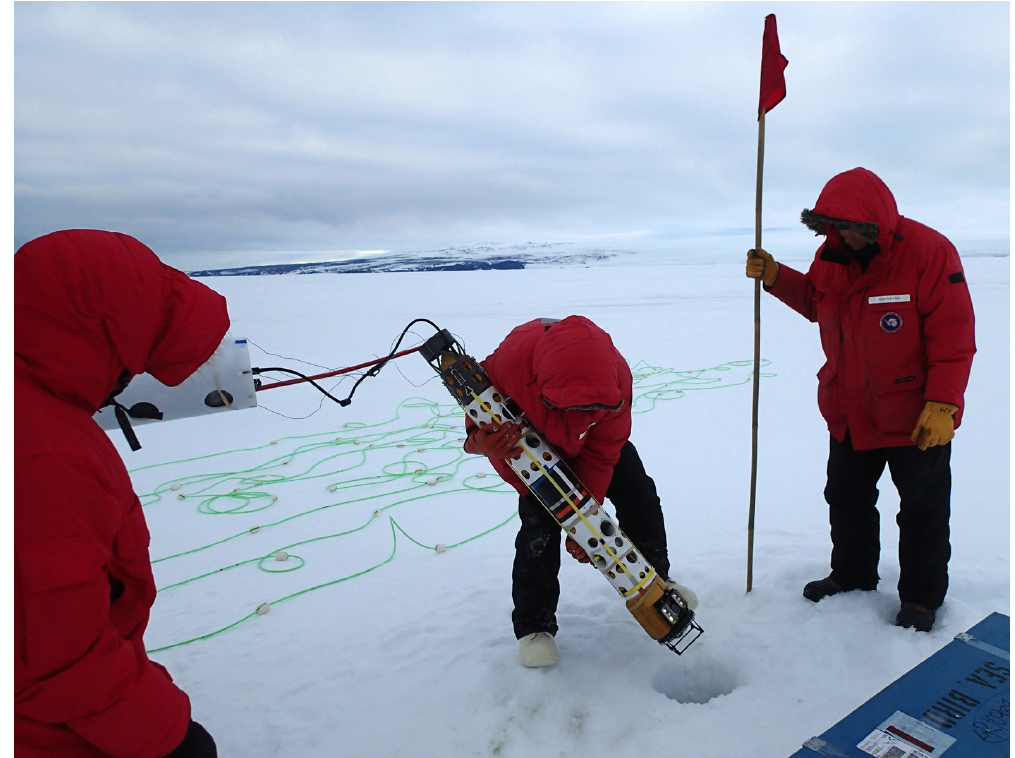
Figure 4. The ROV Submersible Capable of under Ice Navigation and Imaging (SCINI) and Fluorometer and Acoustic Transducer Towable Instrument (FATTI) being deployed through landfast sea ice to map spatial and temporal distributions of chlorophyll (phytoplankton proxy), crystal krill— Euphausia crystallorophias , and Antarctic silverfish— Pleuragramma antarcticum in the McMurdo Sound, Antarctica in November 2014. Image Credit: S. Kim. Reproduced with